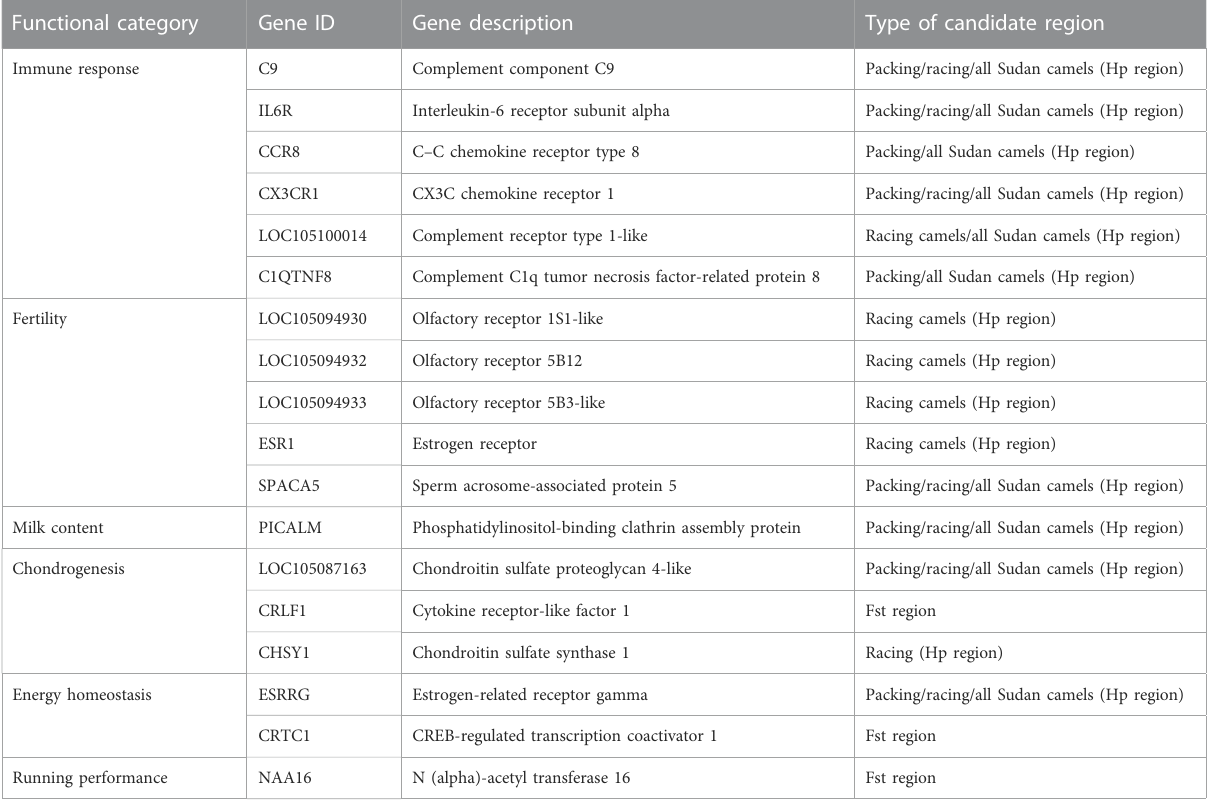
TABLE 3 Candidate regions of genes associated with functional traits in camels. Functional